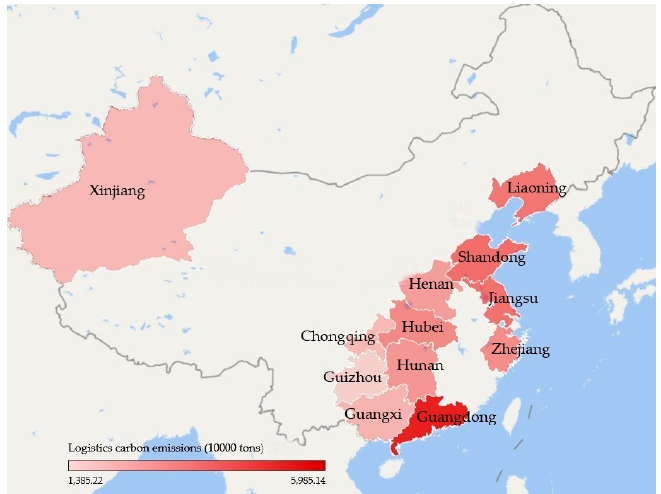
Figure 3. Average annual carbon emissions (10 4 tons) for the logistics industry in the pilot regions.